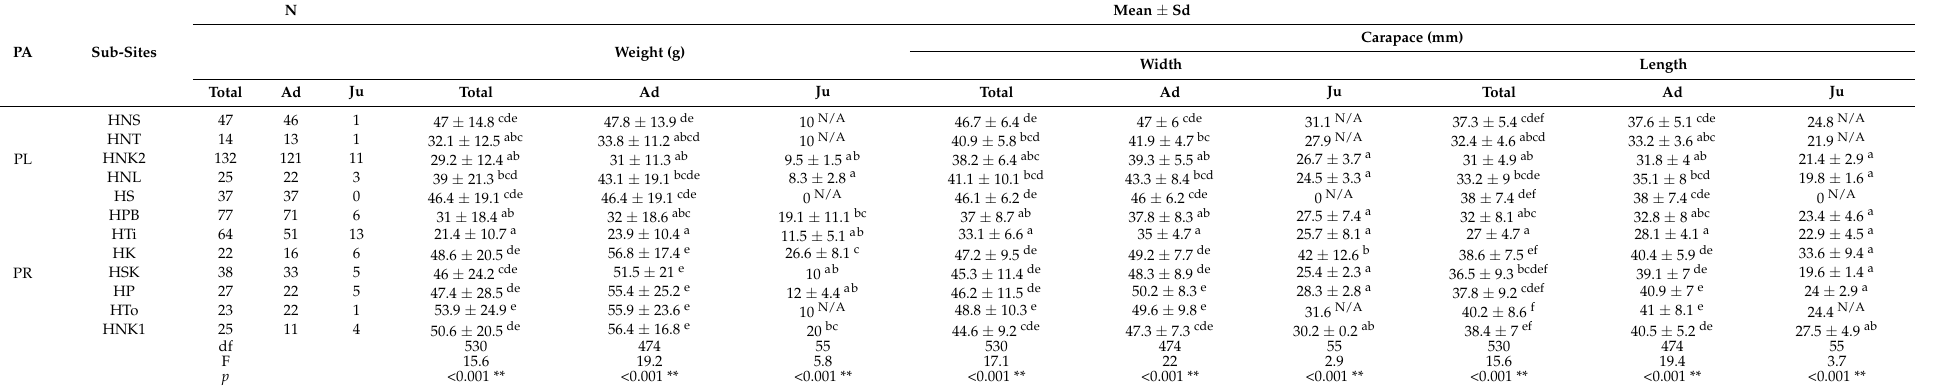
Table 5. Body size of female of I. bhumibol in Phu Luang Wildlife Sanctuary (PL) and Phu Ruea National Park